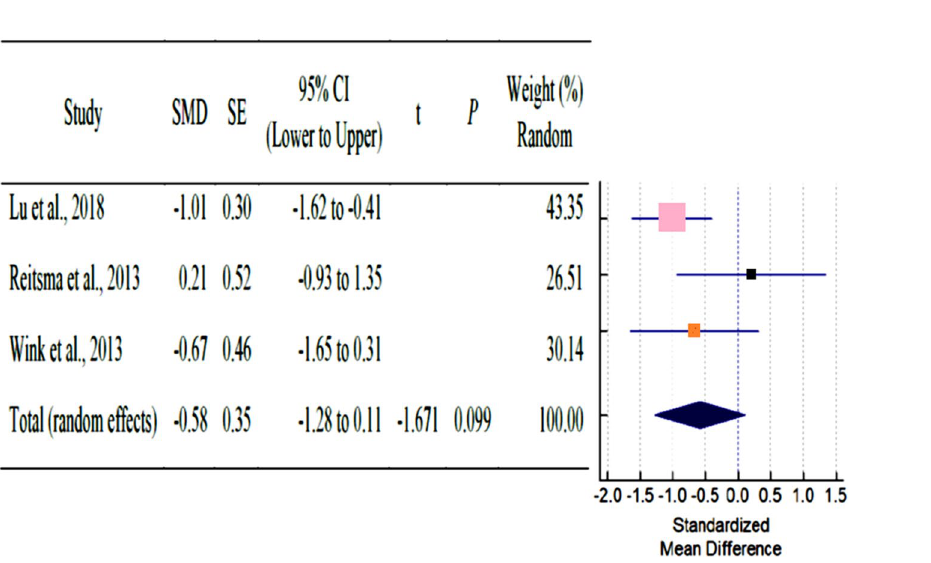
Figure 5. Forest plot for the outcome of